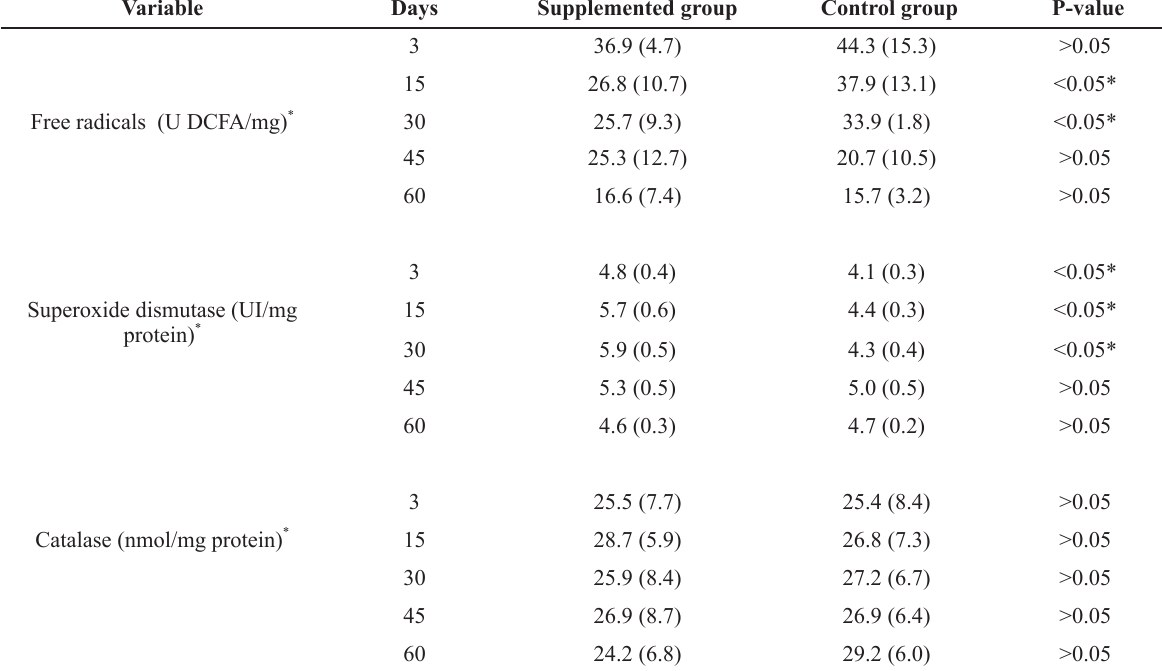
Mean and standard deviation of free radicals, catalase and superoxide dismutase on days 3, 15, 30, 45 and 60 days post- calving of dairy primiparous cows supplemented with injectable minerals during the transitional